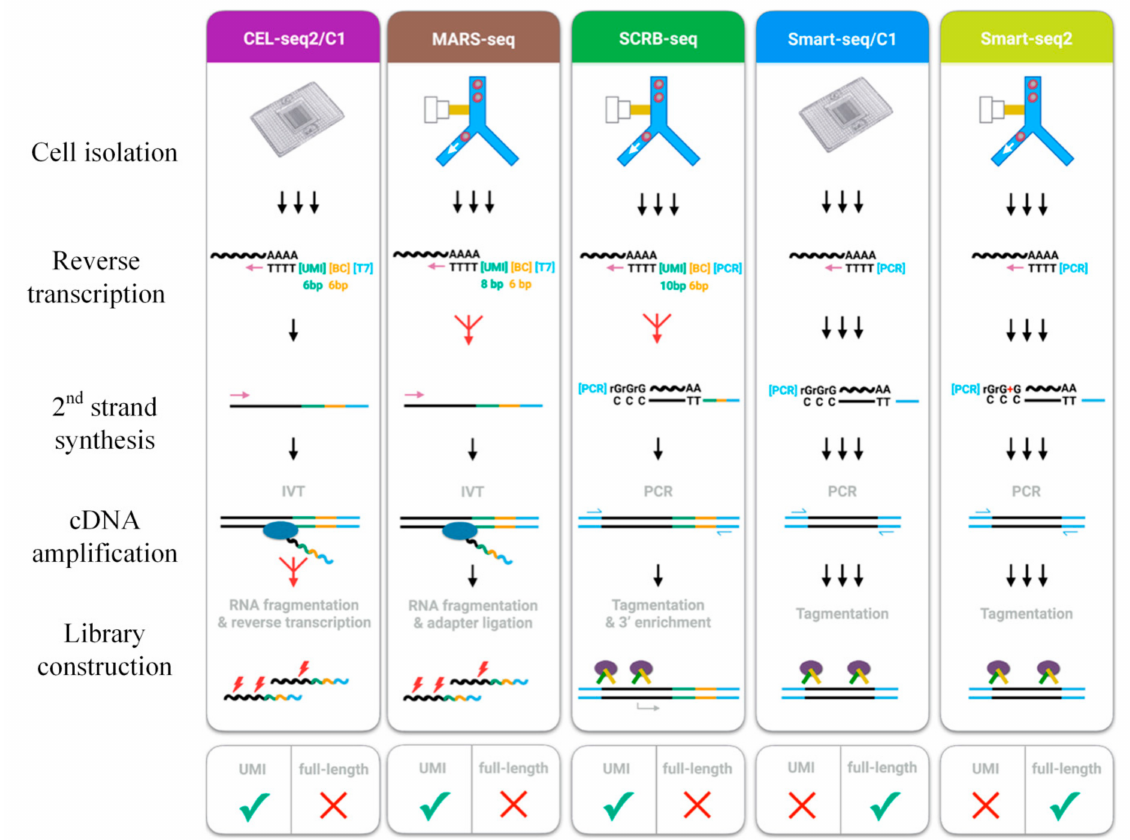
Figure 2. Conventional scRNA-seq. Conventional scRNA-seq technologies include Cel-seq 1 / 2, MARS-Seq, SCRB-seq, and Smart-seq1 / 2. The cells are usually isolated using a micropipette, mouth pipette, or fluorescence-activated flow sorting. They are then lysed and undergo reverse transcription and amplification prior to library construction. Adapted with permission from Reference [36] © Elsevier